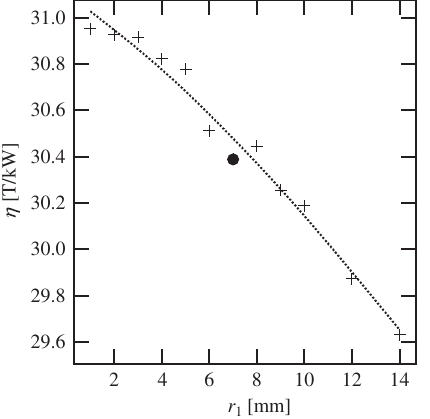
FIG. 7. Magnetic efficiency η vs r 1 pole radius. The dot indicates the design value and the line is a spline interpolation between the simulated points (markers).